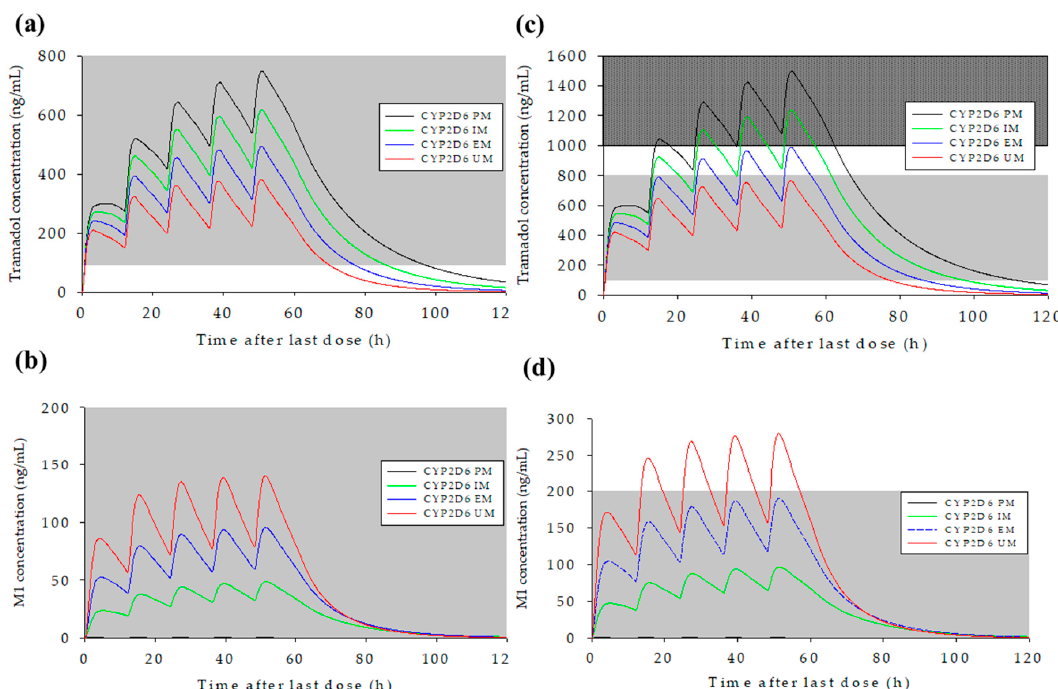
Figure 4. The predicted mean concentration–time profiles after administration of 100 mg and 200 mg tramadol ER tablet twice daily (total five times) for tramadol (a and c), and O -desmethyltramadol (b and d), respectively. Gray areas in ( a ) and ( c ) represent the therapeutic concentration range (100–800 ng/mL); checked gray area in (c) represents the toxic range (above 1000 ng/mL) for tramadol; and the gray area in ( b ) and ( d ) represents the maximum therapeutic range for M1 (up to 200 ng/mL).